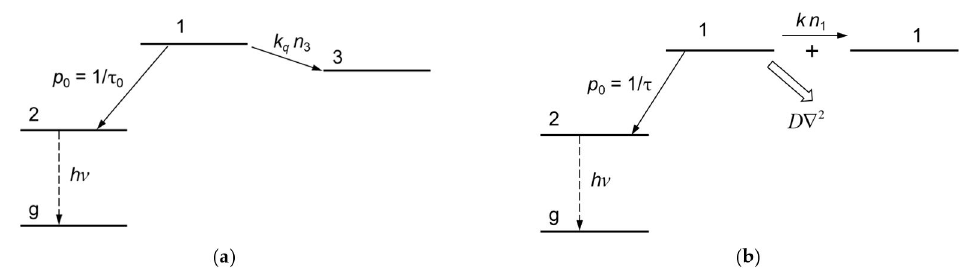
Figure A1. Schematic drawing of quenching. Level 1 is the excited level involved in quenching, level 2 gives fluorescence and level 3 is the quencher. ( a ) Pseudo-first-order reaction. ( b ) Second-order reaction under